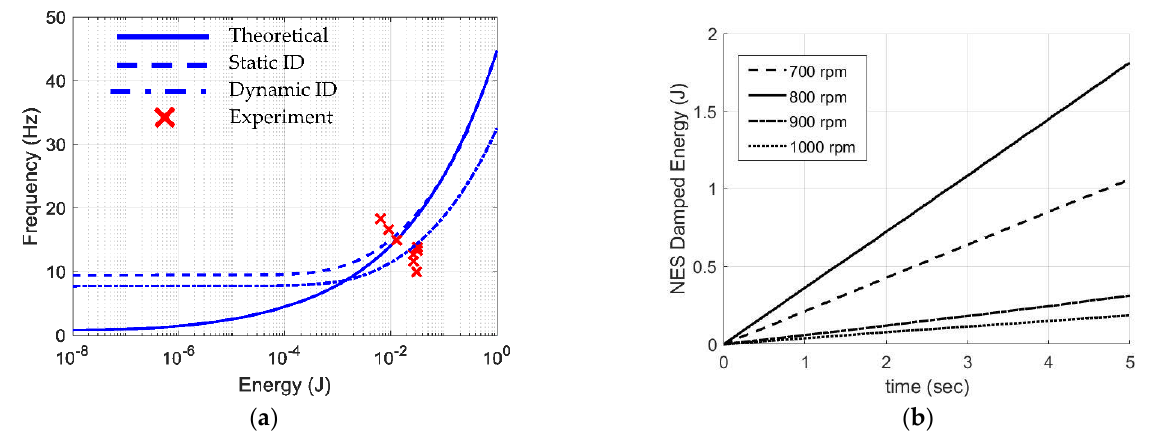
Figure 14. ( a ) Comparison of theoretical NNMs (solid line) with NNM refined from static ID (dashed line), NNM refined from dynamic ID (dash-dot) and active system energies (red x); ( b ) cumulative energy damped by the NES.